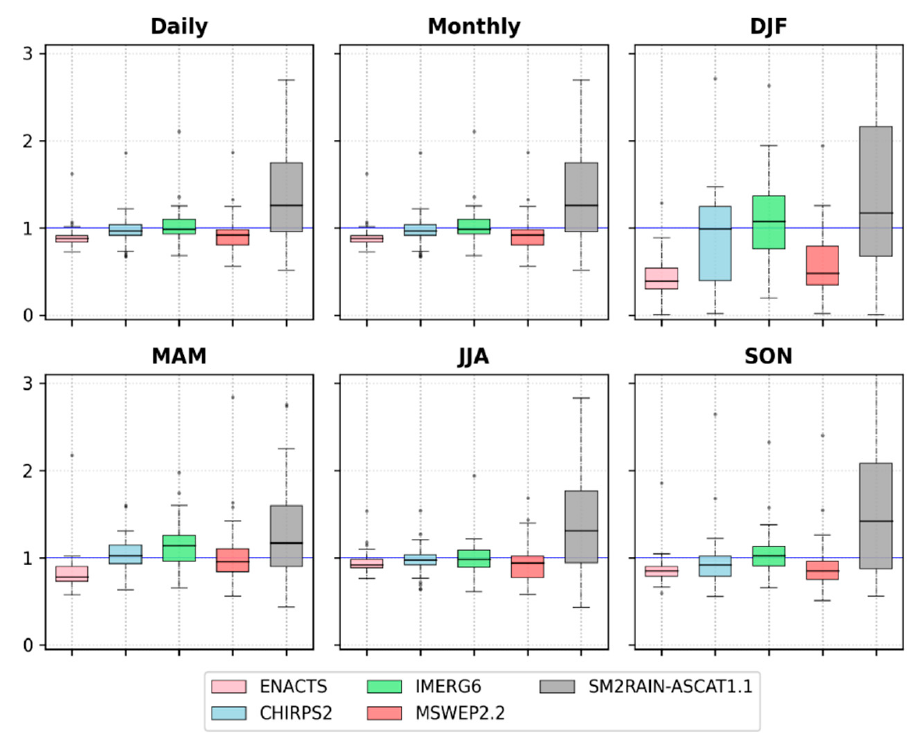
Figure 6. Bias ratio ( β ) between different precipitation datasets and gauge observation at different temporal scales. The horizontal blue line indicates the optimum value for β .